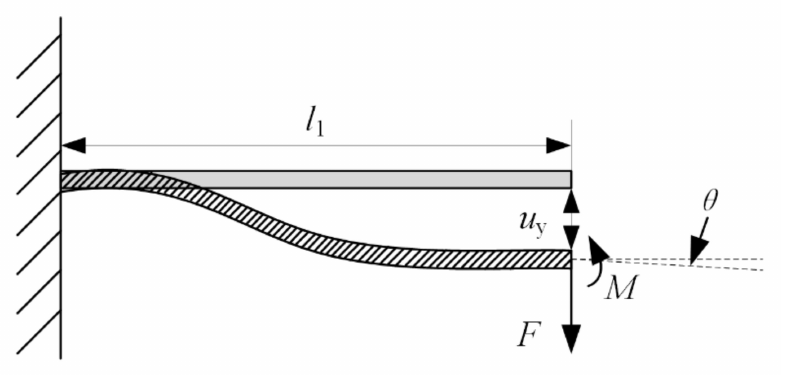
Figure 5. The model of the thin-walled